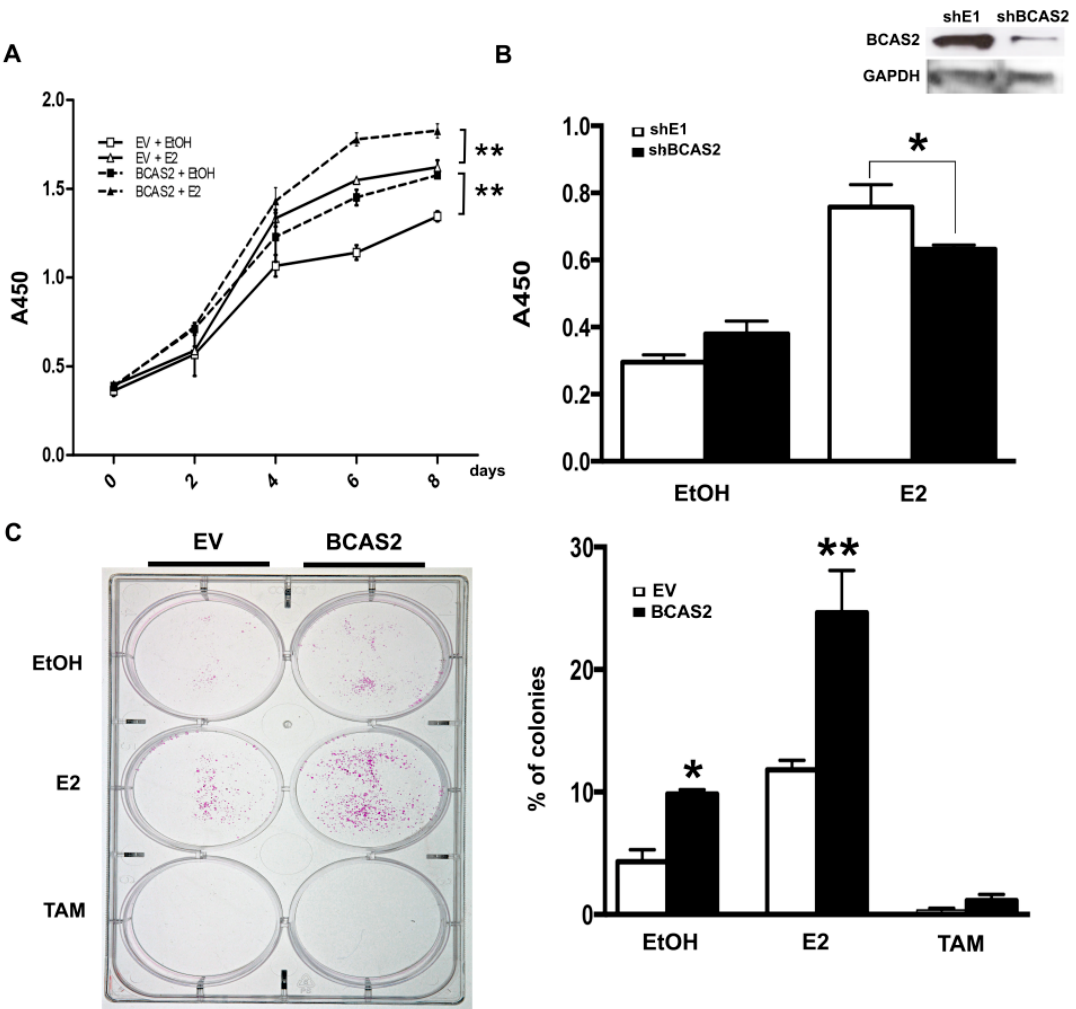
Figure 5. BCAS2 enhances breast cancer cell growth and colony formation. ( A ) Cell proliferation assays were carried out on MCF7 cells transfected with BCAS2 or empty vector (EV) and treated in the absence (EtOH) or presence of E2 for 8 days. Cell viability was assayed every 2 days, as described in materials and methods. BCAS2 overexpression caused a significant increase in proliferation both in the presence and absence of ligand (** p < 0.001) ( B ) Cell viability assays were carried out on MCF7 cells transfected with shBCAS2 or unrelated shE1 in the absence (EtOH) or presence of E2 and assayed after 96 hours. Inhibition of BCAS2 caused a significant reduction in cell growth in the presence (* p < 0.05) of E2. ( C ) Colony formation of MCF7 cells transfected with BCAS2 or empty vector. 1000 transfected cells were plated per well and treated with E2 or TAM every 48 hours for 12 days. Colonies were then stained and counted. Graphical representation of the number of colonies counted with respect to the number of cells plated is shown on right. Data represent three independent assays, * p < 0.05 compared to EV in the presence of EtOH and ** p < 0.001 compared to BCAS2 in the presence of EtOH.